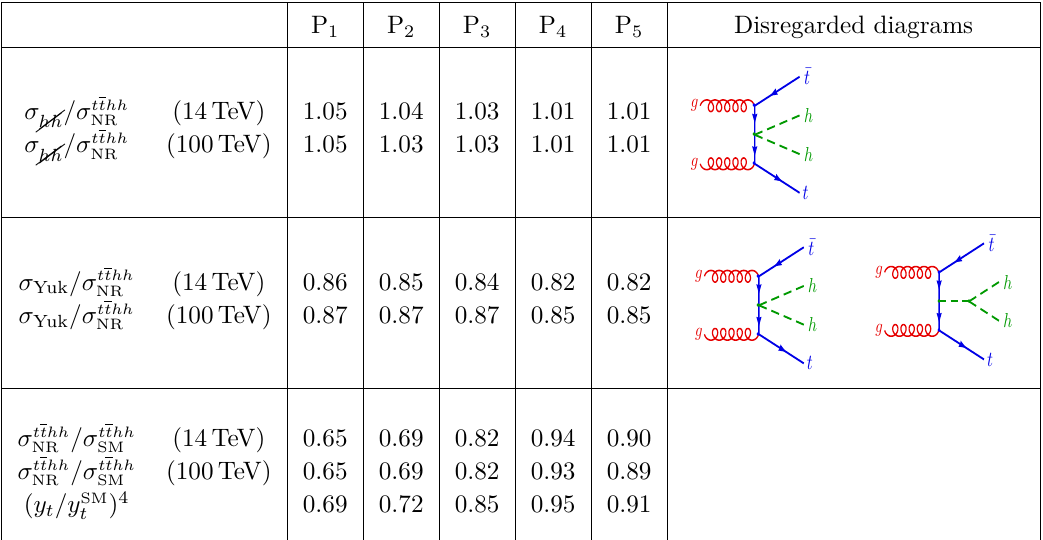
Table 3 . Study of NR- tthh for the MCHM 5 points in table 1. The cross sections σ (cid:26)(cid:26) obtained by disregarding the classes of diagrams on the last column and σ The LO SM tthh production is indicated by σ SM and σ SM Higgs coupling. The top Yukawa couplings are indicated by y t and y SM respectively.